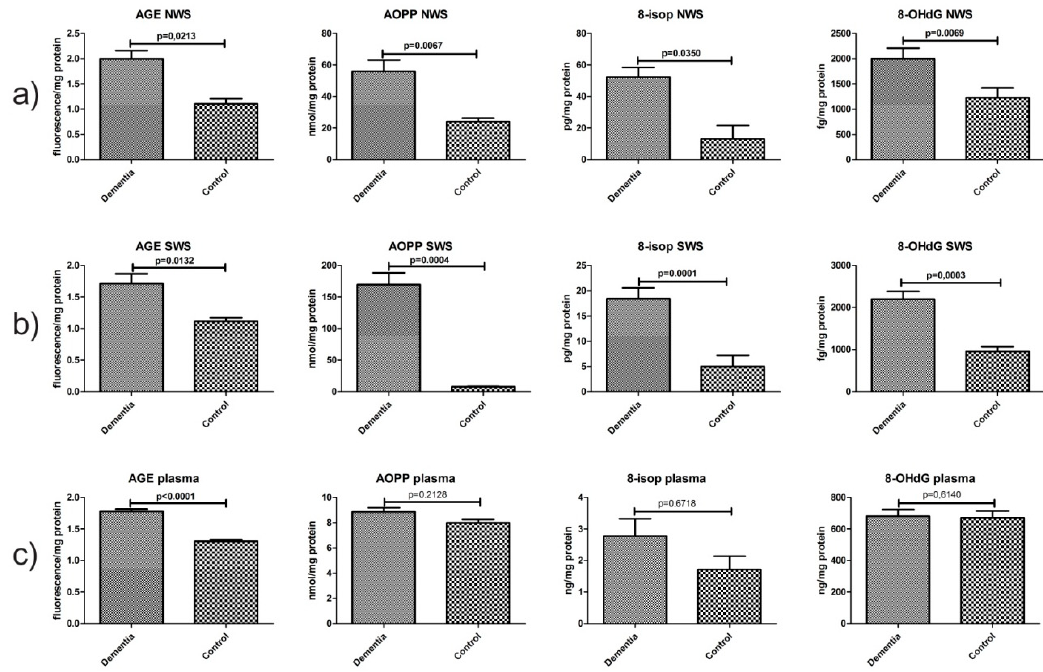
Figure 4. Oxidative damage to proteins, lipids and DNA in non-stimulated ( a ) and stimulated ( b ) saliva as well as plasma ( c ) of dementia patients and the control group. Abbreviations: 8-isop, 8-isoprostanes; 8-OHdG, 8-hydroxy-2 (cid:48) -deoxyguanosine; AGE, advanced glycation end products; AOPP, advanced oxidation protein products; NWS, non-stimulated whole saliva; SWS, stimulated whole